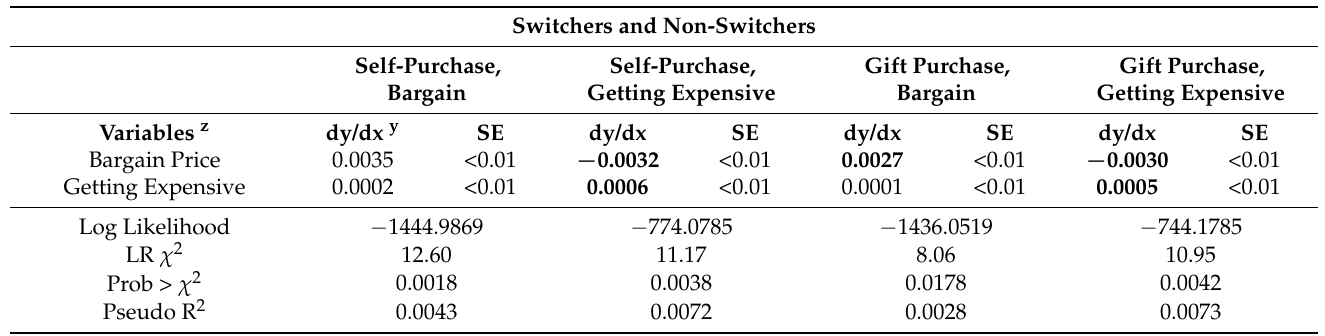
Table 3. Marginal effect estimates from four binary logit models summarizing the effects of the reported bargain and getting expensive prices on switching behavior between switchers and non-switchers ( n = 2094).